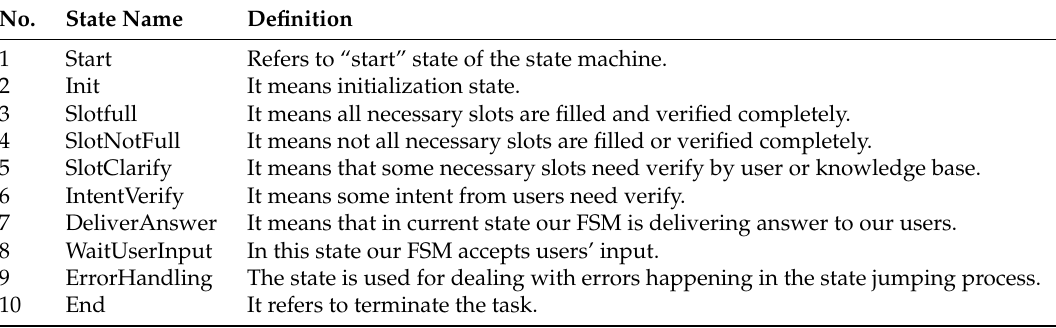
Figure 6. Finite state machine for task-oriented dialog. Table 1. Definition of states.